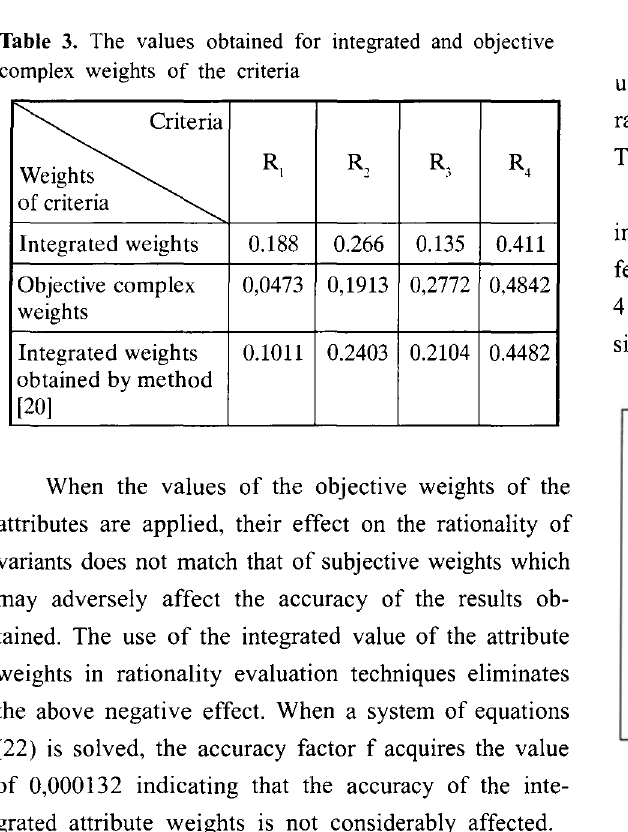
Fig I. The dependence of variant rationality on the type of criteria weights